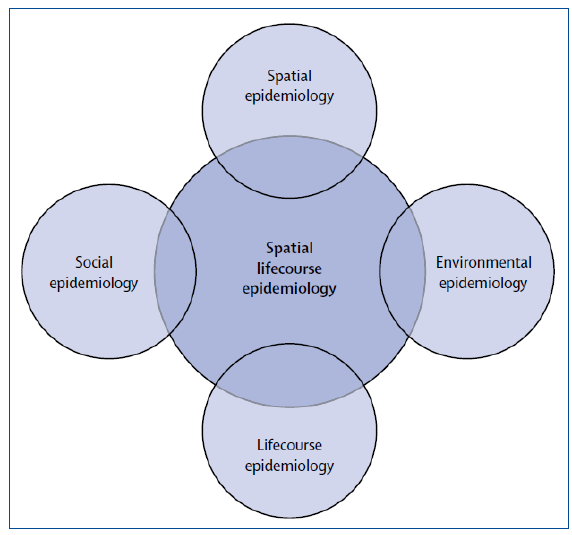
Figure 10 . Conceptual framework of spatial lifecourse epidemiology (P. Jia, 2019)